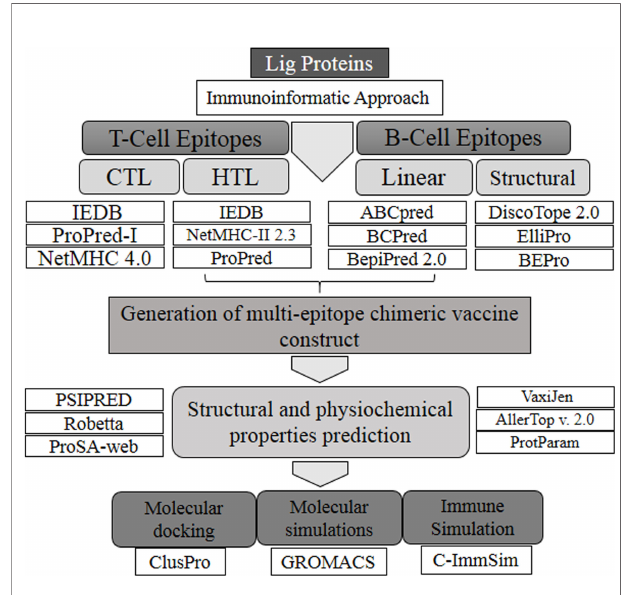
FIGURE 1 | Flowchart of the methodology followed for this